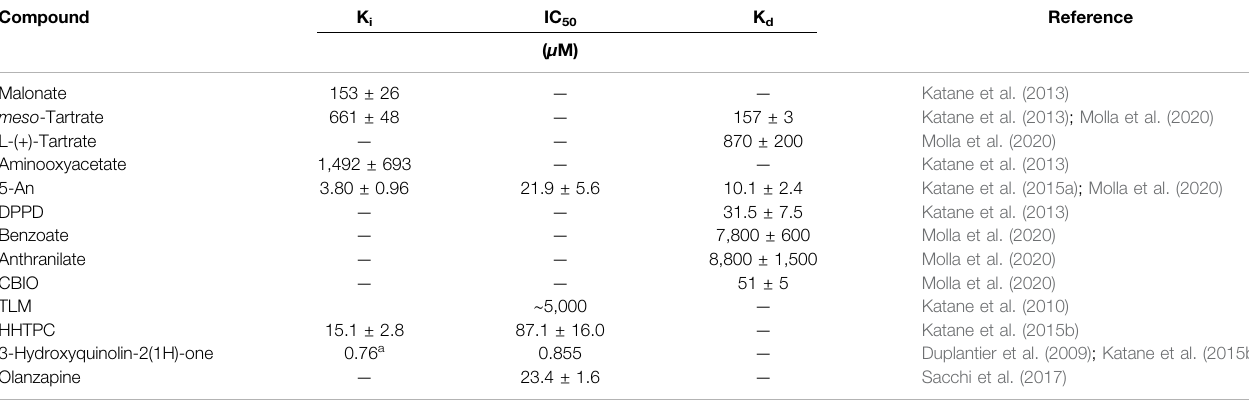
TABLE 3 | Inhibitors of hDASPO: inhibition and binding constants.